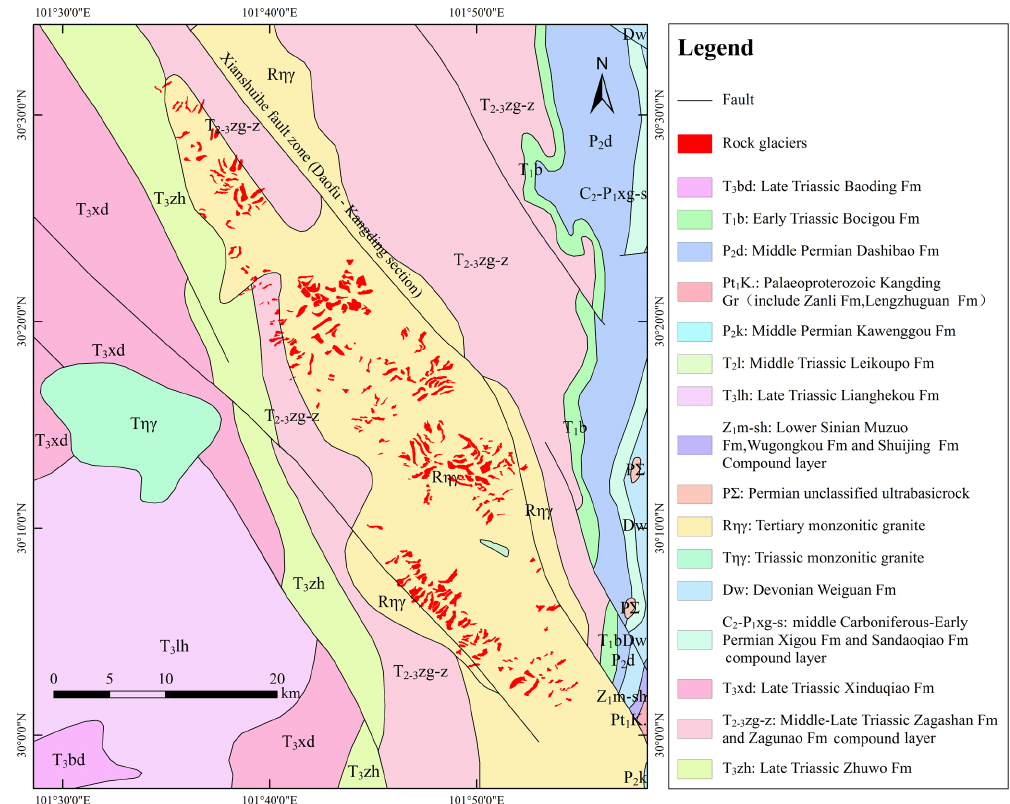
Figure 6. The rock glaciers of Daxue Shan superimposed on the local lithologic–geologic environment. Stratigraphic data from Li et al. (1999).